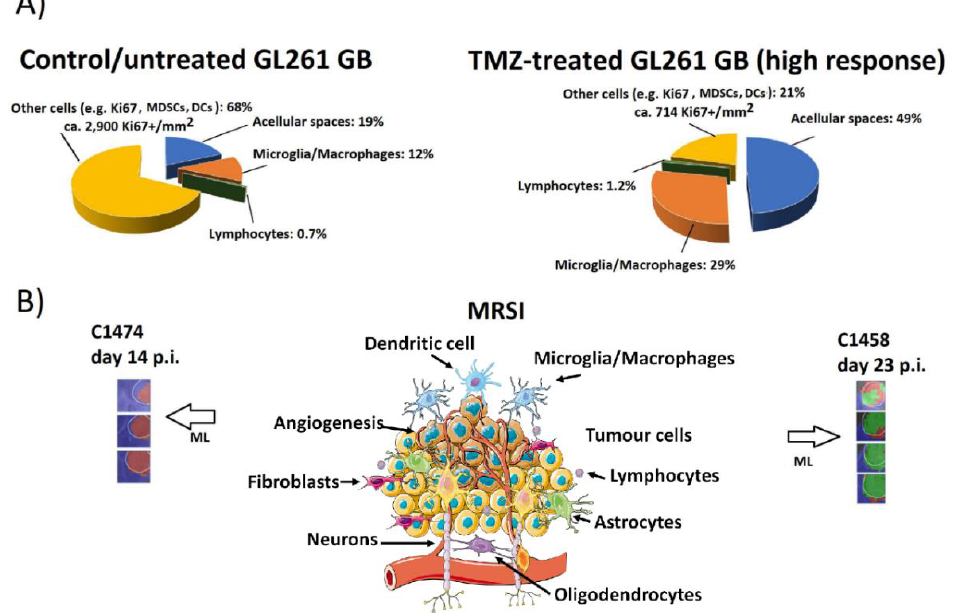
Figure 1. Summary of changes detected in control/untreated and TMZ-treated (high response level, see [43] for definitions) GL261 GB. ( A ) Graph showing average percentages of histopathological features, transformed into volume percentage occupied in the tumor tissue. CD3/Iba-1 immunostaining was used for staining lymphocyte populations and microglia/macrophage populations, respectively. Ki67+ cells refer to GL261 GB tumor cells. The total number of studied histology fields was n = 35 to 45 for control and n = 22 to 25 for TMZ-treated cases, from a total of four selected mice described in [43] ( n = 2 control and n = 2 TMZ-treated). Response levels were determined through MRSI-based nosological images prior to euthanization. Selected fields corresponded to zones identified as “actively proliferating” (control cases) and “responding” (TMZ-treated cases). ( B ) Scheme of the complex tumor-microenvironment constituted by different elements as described in ( A ), which are variable in control and TMZ-treated, responding cases. At each side, the corresponding MRSI-based nosological images obtained with machine learning approaches (ML) are shown. Left, a representative control case (C1474, 14 days postimplantation (p.i.) of GL261 cells into the striatum of C57BL/6j mice). Right, a representative TMZ-treated, transiently responding case (C1458, 23 days p.i.) from [56]. Please note that each studied mouse was identified in the cited studies with a unique code (CXXXX) where XXXX was a correlative number. The color code in the nosological images was red for proliferating tumors, green for responding tumors, and blue for normal tissue. The Tumor Responding Index (TRI, please refer to Supplementary Material section) was calculated and achieved values of 0% (control case) and 81.8% (TMZ-treated, responding case), most probably reflecting a combination of the cellular/tissular elements changes shown in ( A ). The TRI was then calculated taking into account the percentage of pixels classified as “responding” (green) divided by the total pixels counted within the tumor mass. The